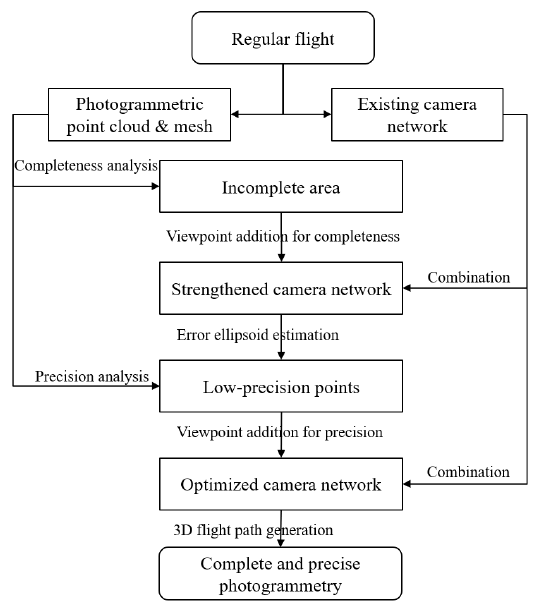
Figure 1. Flowchart of the proposed path planning